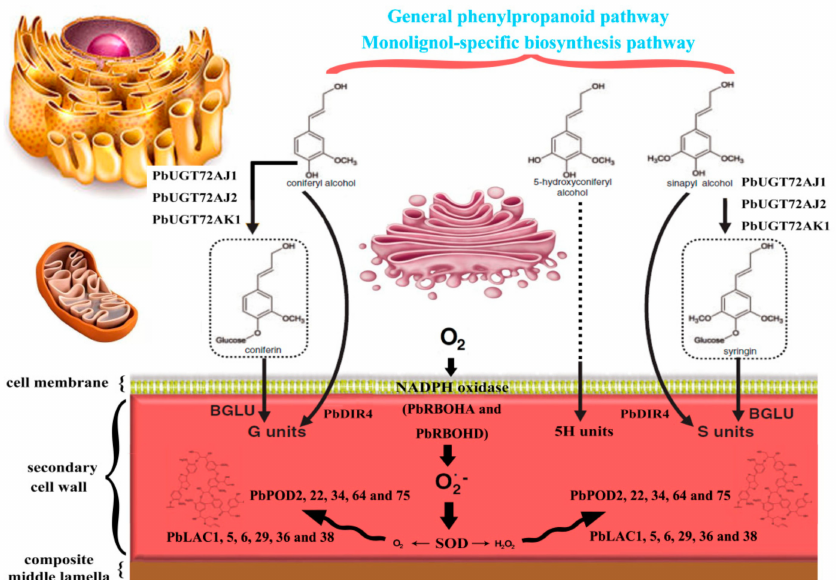
Figure 13. A model of reactive oxygen species (ROS) metabolism and lignin monomer polymerization in pear